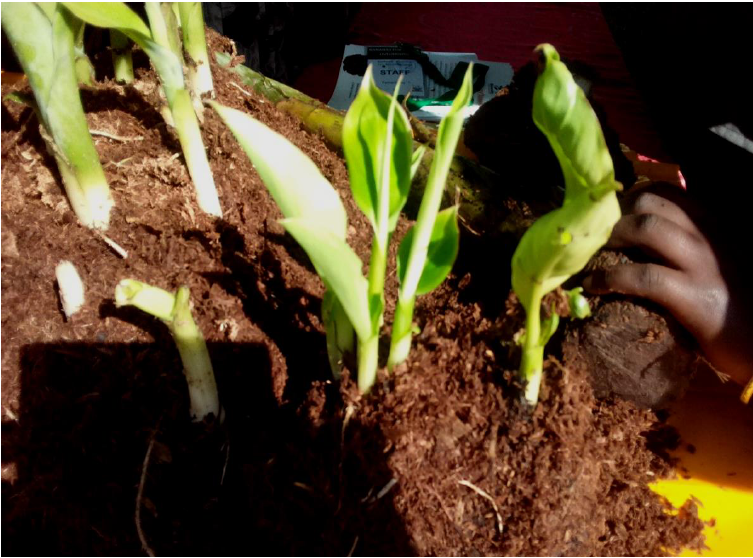
Figure 4: Macropropagation of bananas by planting whole corms in moist nursery